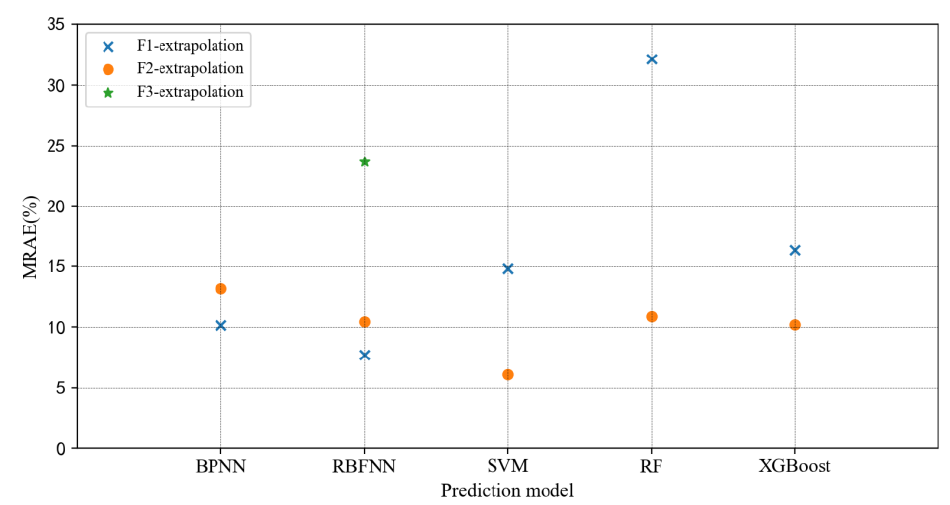
Figure 9. The MRAE of extrapolation prediction under different models. The optimal predicted resistance coefficient C t is converted to the corresponding resistance R t . The experimental values and predicted values of each sample point in the test set are shown in Table 11. The curves of C t versus Fn and the curves of R t versus V m at draft = 0.209 m and draft = 0.275 m are shown in Figures 10 and 11, respectively.